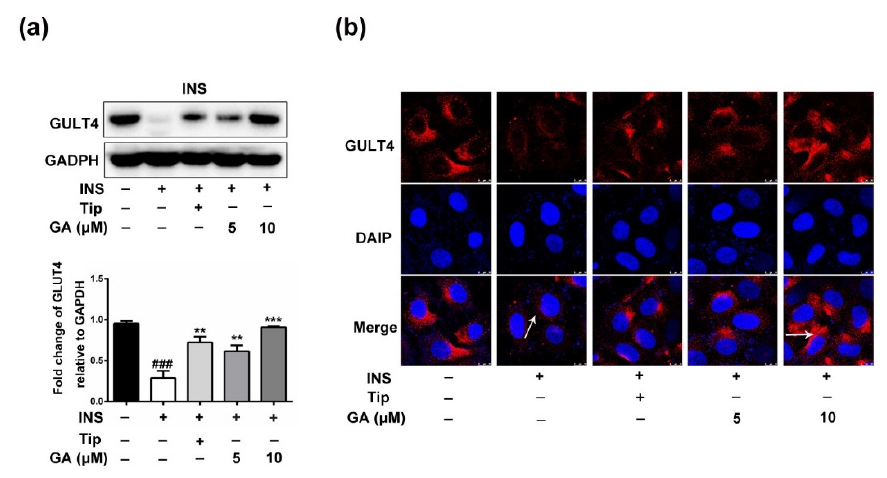
Figure 4. Effect of GA on GLUT4 expression. ( a ) GA significantly promoted the expression of GLUT4 protein. After the cytoplasmic proteins were extracted, the expression level was detected using anti-GLUT4 specific antibodies. ( b ) GA significantly promoted the expression of GLUT4, observed by immunofluorescence staining, and the photographs were captured on an inverted fluorescence microscope. Error bars indicate the mean ± S.D ( n = 3) (** p < 0.01, *** p < 0.001, ### p < 0.001 compared to the activated insulin signaling pathway